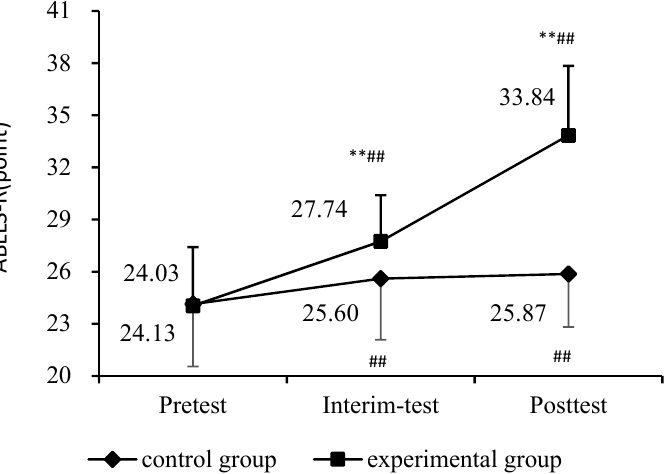
Figure 3. Impact of THR program on the ABLLS-R in the two groups. Compared with the control group, ** p < 0.01. Compared with pre-test, ## p < 0.01.